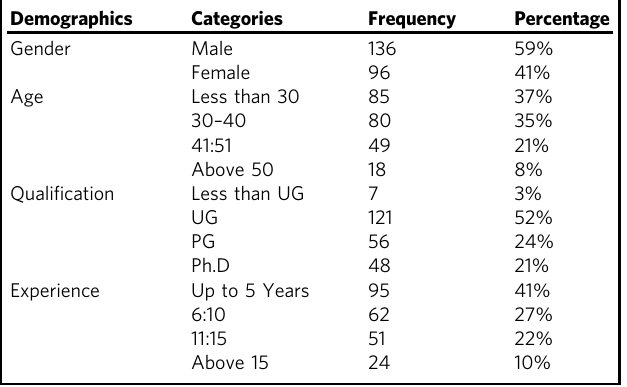
Table 3 Respondents ’ pro fi